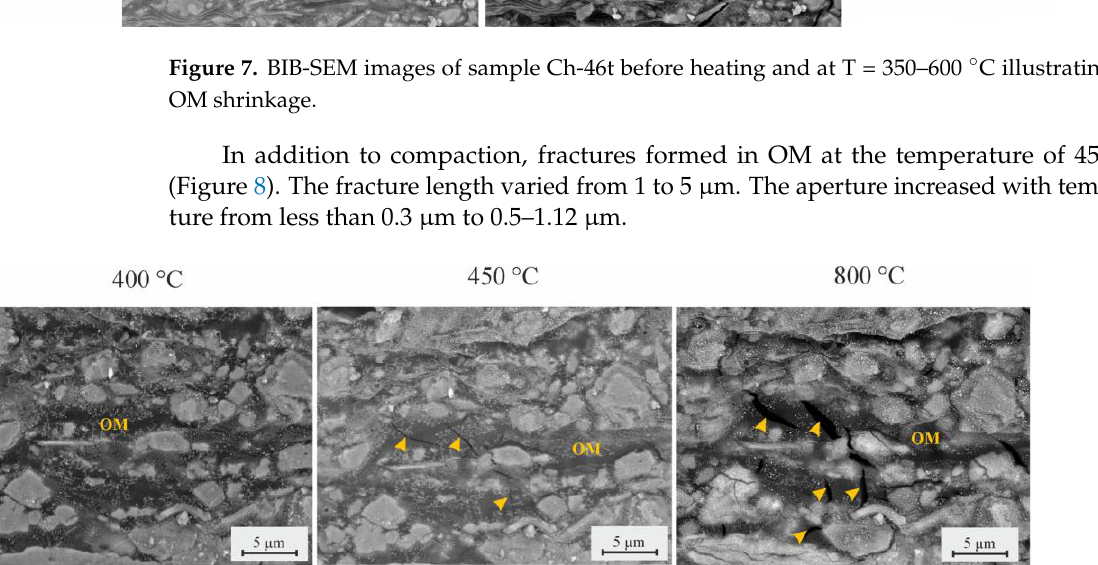
Figure 7. BIB-SEM images of sample Ch-46t before heating and at T = 350 – 600 °C illustrating the OM shrinkage.